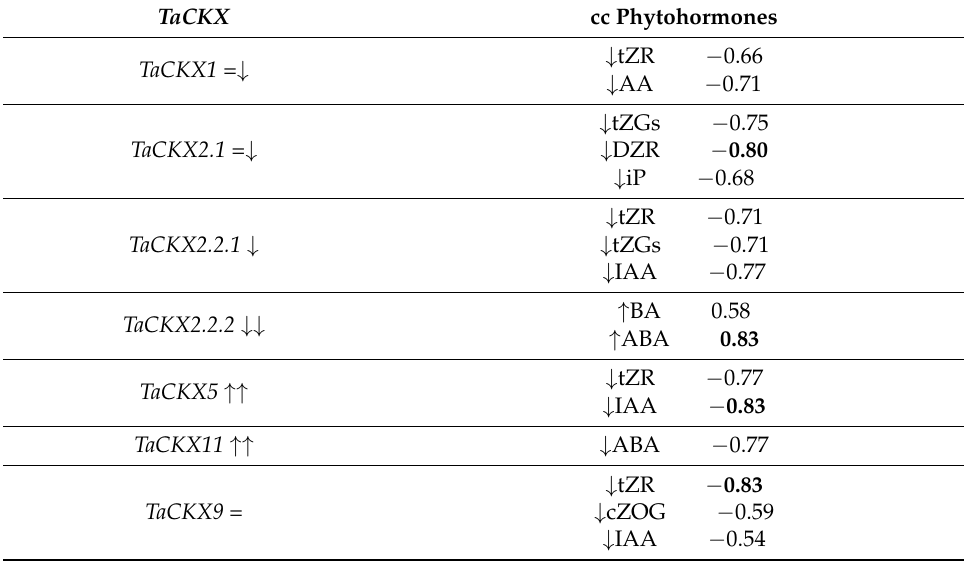
Table 1. Correlation coefficients between TaCKX GFMs and phytohormones. Values in bold are significant at p < 0.05. = not changed; = ↓ slightly silenced; ↓ silenced or down-regulated; ↓↓ highly silenced, significant; ↑ increased expression or up-regulated